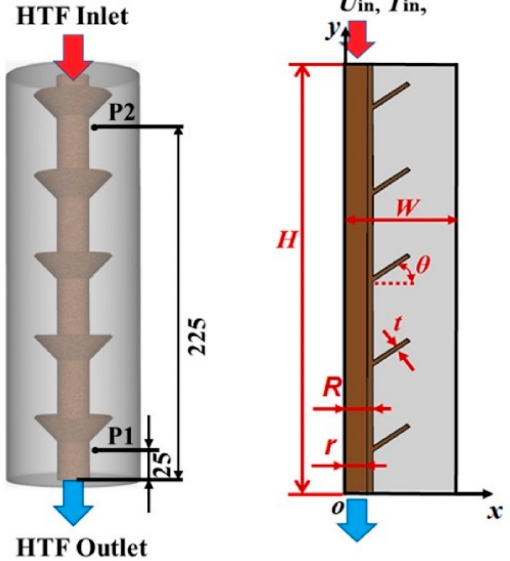
Figure 4. LHTES unit with annular fins [52]. (Permission to reproduce from Ref. [52]). Perforating on annular fins could enhance the natural convection. Karami and Kamkari [55] compared finless, holeless annular fins and perforated annular fins LHTES units. The average Nusselt number of perforated fin structure was about 30% higher than that of a holeless fin structure, and the total melting time was reduced about 7%. Li et al. [56] considered that increasing the diameter of the hole on the annular fin or decreasing the distance from the hole to the fin root would enhance the natural convection and weaken the heat conduction. The melting time could be reduced about 5.49% by selecting the optimum hole diameter and